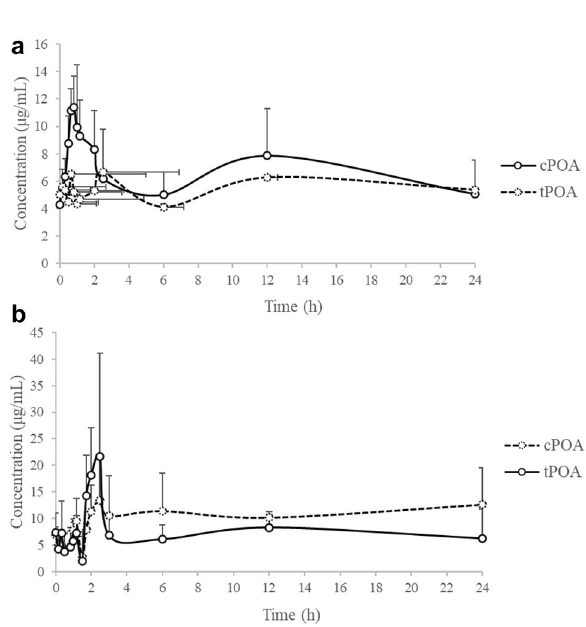
Figure 4. Mean serum concentration–time profiles of c POA and t POA (n = 6). ( a ) Showed c POA and t POA concentrations after i.g. administration of c POA in rats at 75 mg/kg body weight, ( b ) showed c POA and t POA concentrations after i.g. administration of t POA in rats at 75 mg/kg body